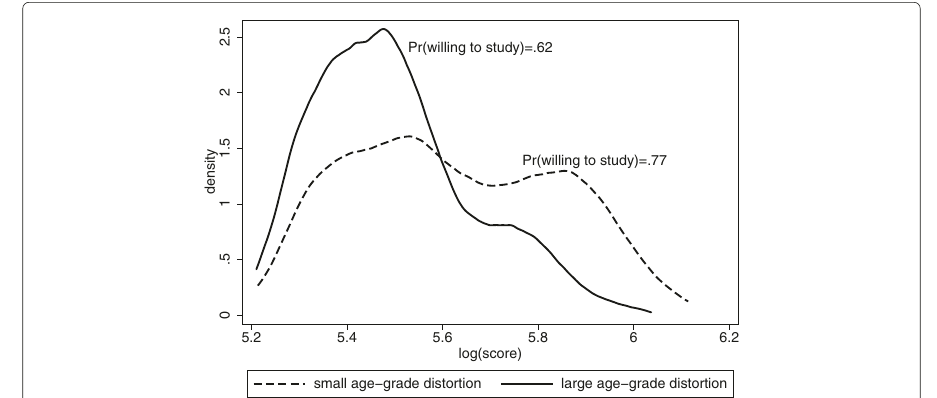
Fig. 2 School graduates, willingness to study, and positive selection. This figure shows two density estimates of the SAEB score for high school graduates in the state of Pernambuco. One is from a sample of students who are 18.5 years or younger ( dashedline ) and the other is from those older than 18.5 years ( solid ). This figure also displays the conditional percentage of students that answered “yes” when asked about